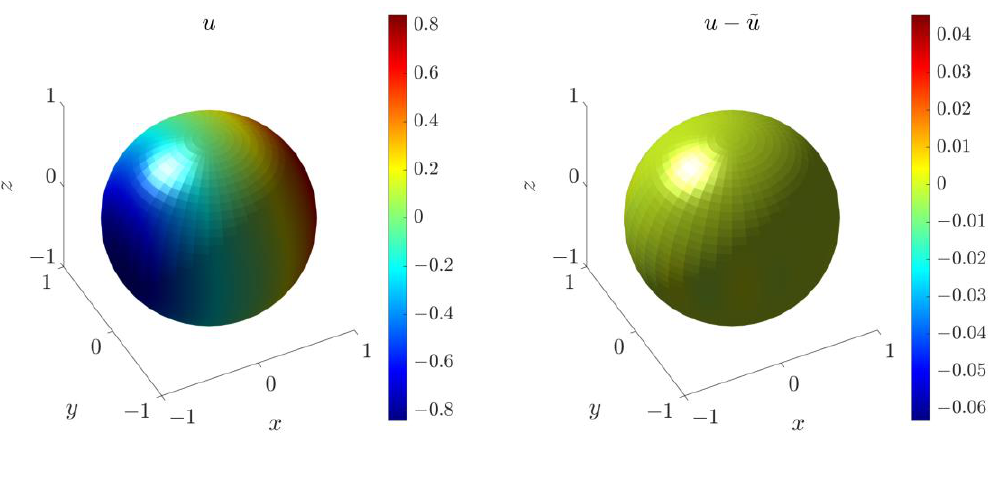
Figure 27. Solution and corresponding error at y = 0 for the 3D parameter identification problem in spherical domain under different discretizations: ( a ) N s = 7 × 7 × 7; ( b ) N s = 9 × 9 × 9; ( c ) N s = 11 × 11 × 11.